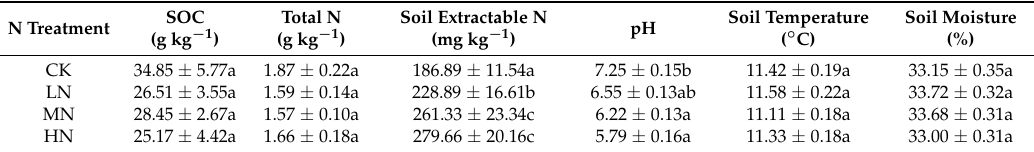
Table 2. Comparisons of soil organic C (SOC), total and extractable N, pH, soil temperature and moisture after 5-year N addition in the Pinus tabulaeformis forest. CK, LN, MN and HN denote control, low N, medium N and high N treatment, respectively. Significant differences ( p < 0.05) by N treatments were labeled with different letters across columns. SOC and MBC represents soil organic C and microbial biomass C, respectively. Data are mean ±